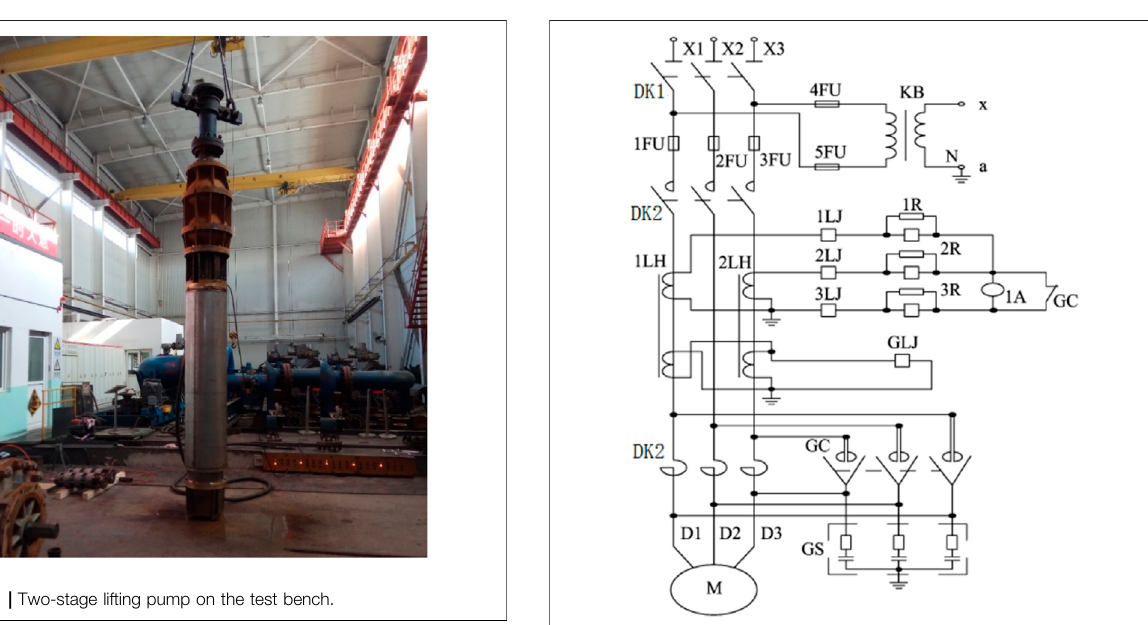
FIGURE 12 | Control main circuit.